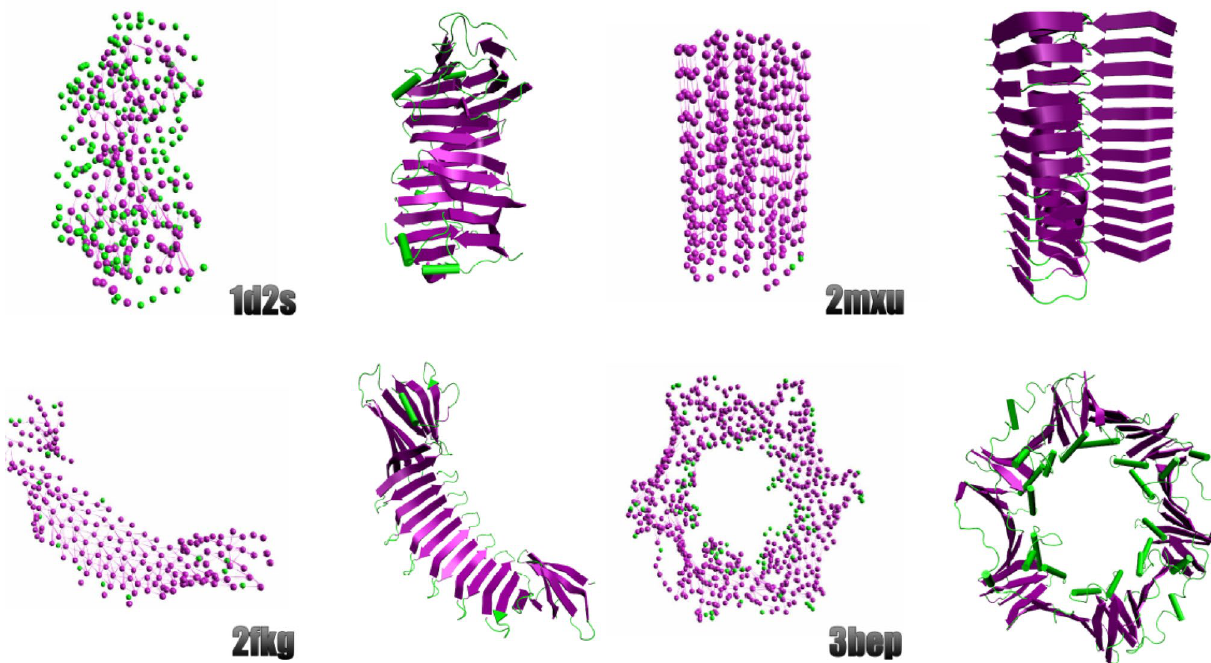
Figure 2. Validation of HyperBeta on different protein structures. Four PDB structures were analyzed with STRIDE and then compared to HyperBeta. The structures are (clockwise): the Laminin G-like domain (PDB ID: 1d2s); 42-residue β -amyloid fibril (PDB ID: 2mxu); the E. coli β -clamp (PDB ID: 3bep); engineered OspA (PDB ID: 2fkg). In each pair, the β -sheets (coarsened by the CG model) calculated by HyperBeta are shown on the left, while the corresponding united-atom structures rendered by VMD are shown on the